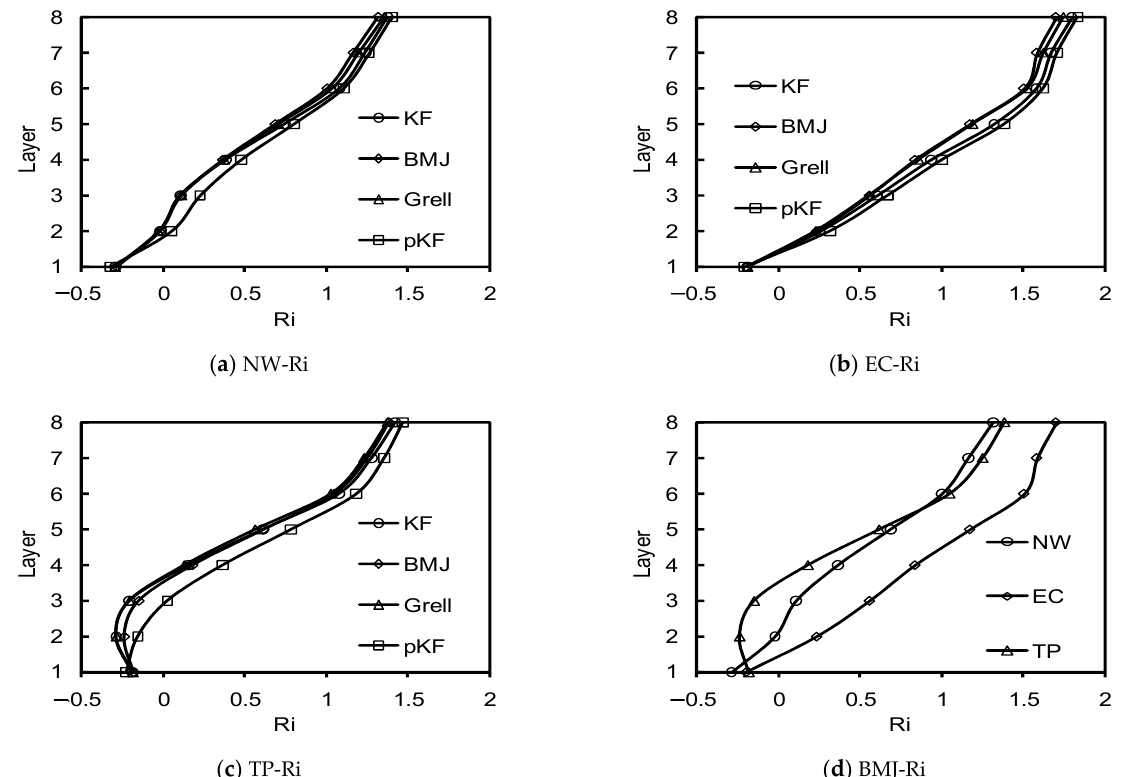
Figure 5. Ensemble seasonal mean Richardson number ( R i ) in the selected atmospheric boundary layer in the three sub ‐ regions, where Layers 1–8 are approximately 10, 30, 100, 200, 320, 470, 600, and ∆ θ ∆ z 900 m above ground level, respectively, with R i = g , where ∆ θ represents the potential θ [( ∆ U ) 2 +( ∆ V ) 2 ] temperature difference between the top and bottom of the atmospheric layer, ∆ z the thickness of the layer, θ the mean potential temperature, and ∆ U ( ∆ V ) the zonal (meridional) wind speed difference between the top and bottom of the atmospheric layer [33]. ( a ) The four CPS ensembles for NW; ( b ) same as ( a ) but for EC; ( c ) same as ( a ) but for the TP; ( d ) the BMJ ensemble for the three